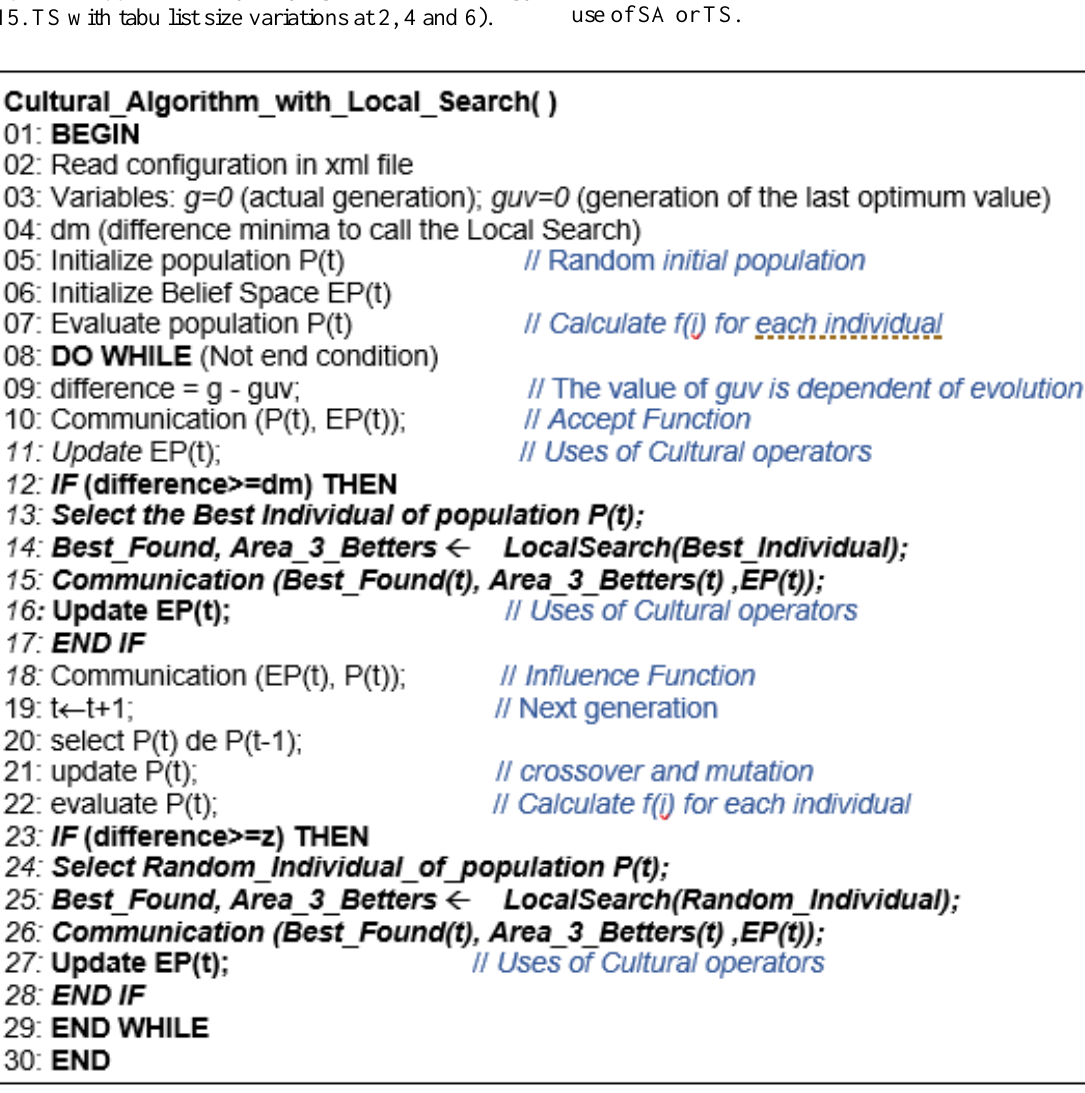
Figure 3: Pseudocode of the proposed